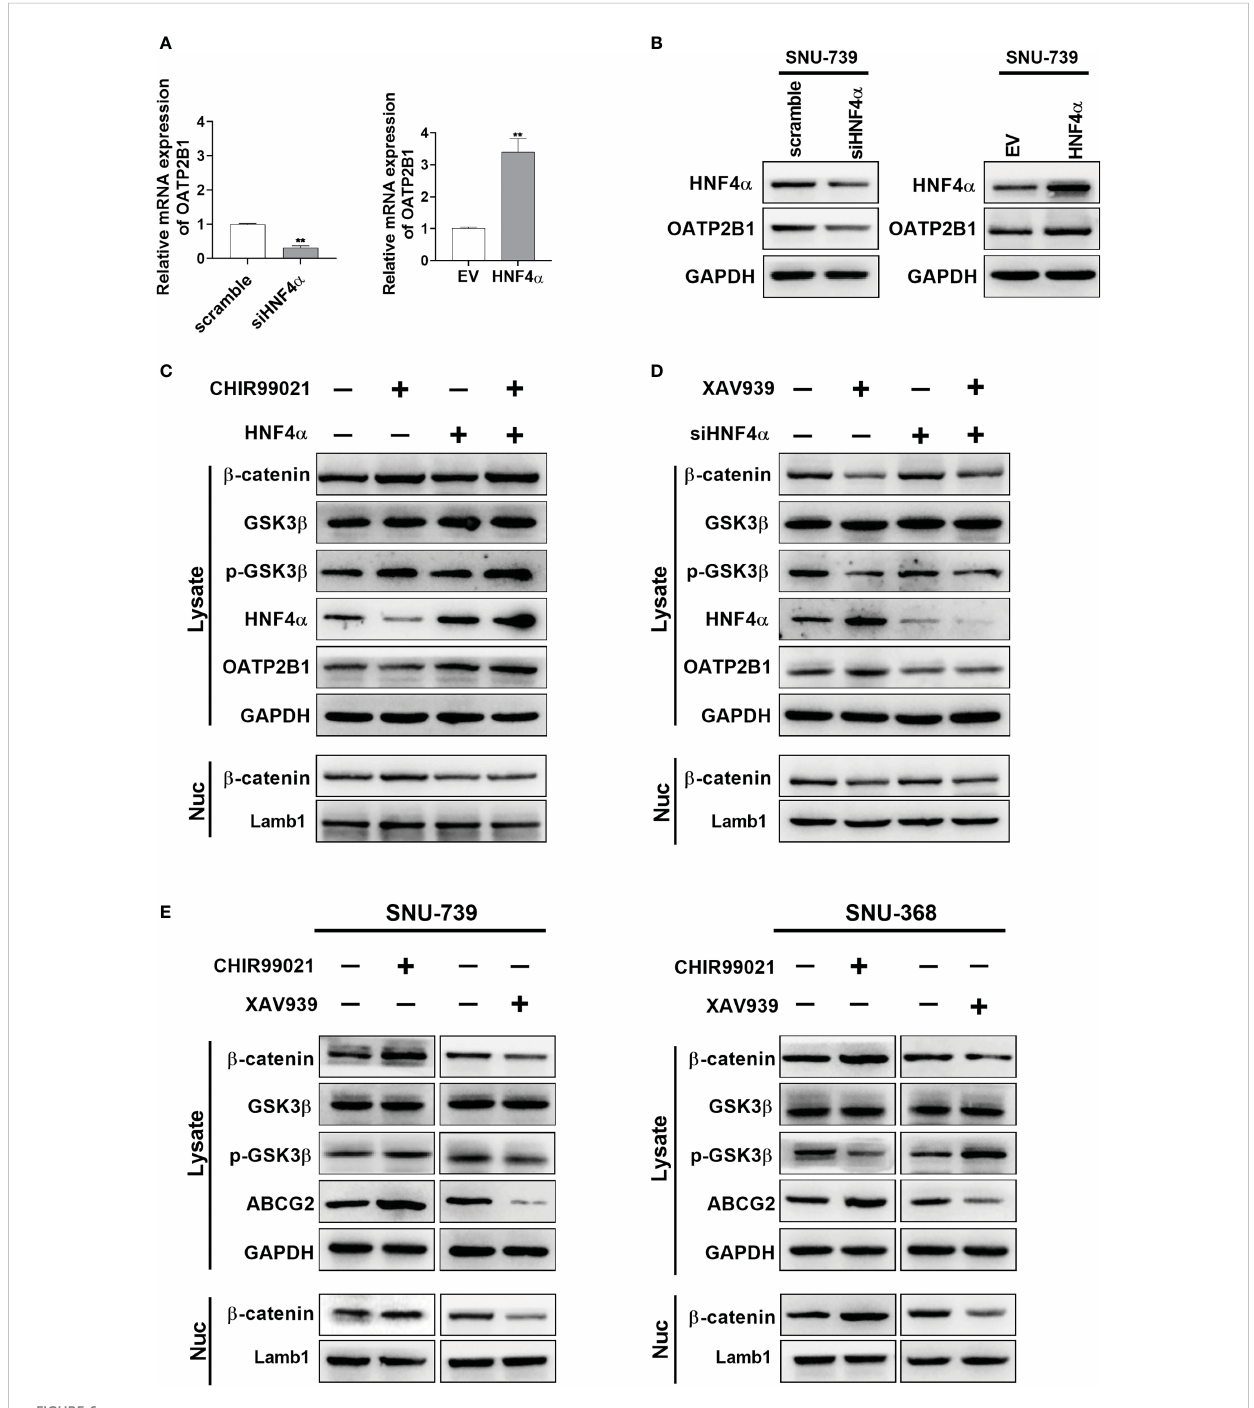
FIGURE 6 b -catenin signaling pathway is involved in regulation of OATP2B1 and ABCG2 in HCC cells. (A, B) QRT-PCR and western blotting analyses of OATP2B1 expression in SNU-739 cells with treatment as indicated. (C, D) Western blot analysis for b -catenin, GSK3 b , p-GSK3 b , HNF4 a , and OATP2B1 in HCC cells with a panel of treatment as indicated. XAV939: cells were treated with XAV939 (5 m M) for 48 hours. CHIR99021: cells were treated with XAV939 (5 m M) for 48 hours. (E) Western blotting analysis for b -catenin, GSK3 b , p-GSK3 b , HNF4 a , and ABCG2 in HCC cells with treatment as indicated. XAV939: cells were treated with XAV939 (5 m M) for 48 hours. CHIR99021: cells were treated with XAV939 (5 m M) for 48 hours. Data shown are the mean ± SD from three independent experiments, where appropriate. **P <